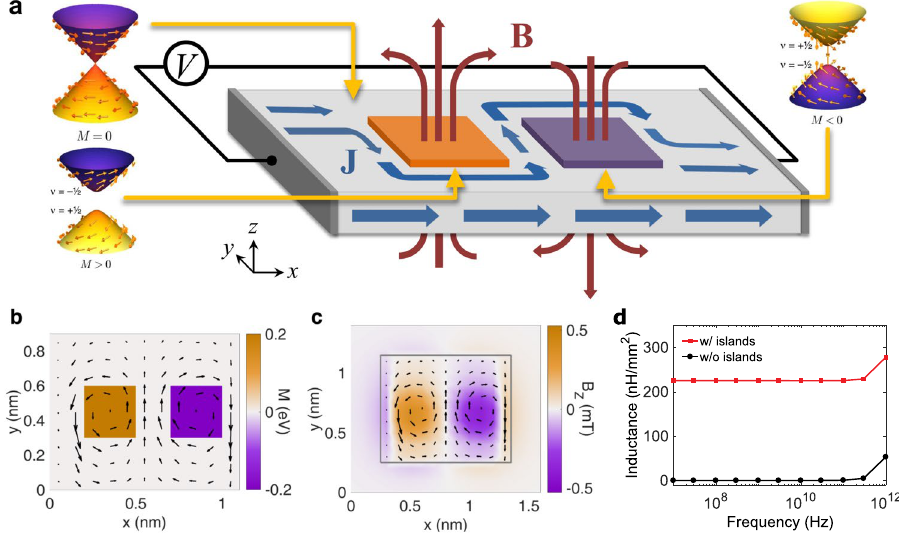
Figure 2. Schematic and ideal operation of the topological inductor. ( a ) A schematic of a two-island topological inductor that utilizes the surface states of a time-reversal-invariant TI. By alternating the magnetization of each subsequent island, indicated by the orange and purple squares, under bias, the surface current density wraps around the FIs because of the QAHE induced by the ferromagnetism. The altered motion of the current around the islands concentrates magnetic energy through the islands, resulting in enhanced inductance. ( b ) The self- consistent AC NEGF simulation of the the current density in the top surface of a topological inductor under an AC bias of 10 mV reveals the circulating currents generated by the QAHE. The FIs are indicated by the two colored squares where the Zeeman field M is nonzero, and the current density by the black arrows. ( c ) The resulting ^ z -directed magnetic flux density B z at an AC bias of 10 mV, where the gray outline indicates the position of the inductor. The electromagnetic domain is larger than the NEGF domain to capture any fringing and radiating fields. ( d ) The frequency response of the topological inductor demonstrates high inductance density up to terahertz